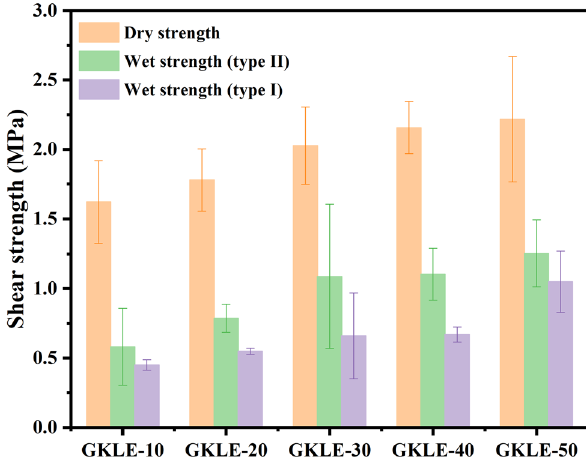
Figure 6: E ff ect of di ff erent ECH contents on the shear strength.